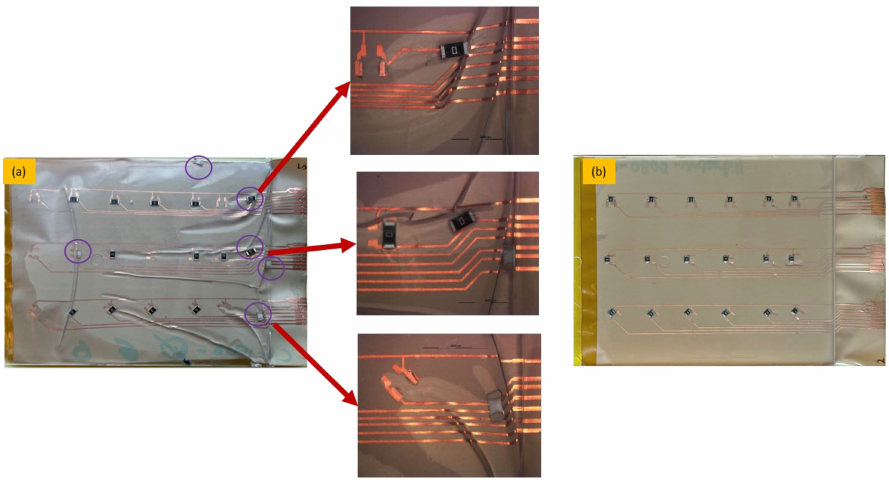
Figure 30. Bad over-molding with misplaced foil, removed components and wrinkles ( a ), good over-molded foil with all components and without wrinkles ( b ).